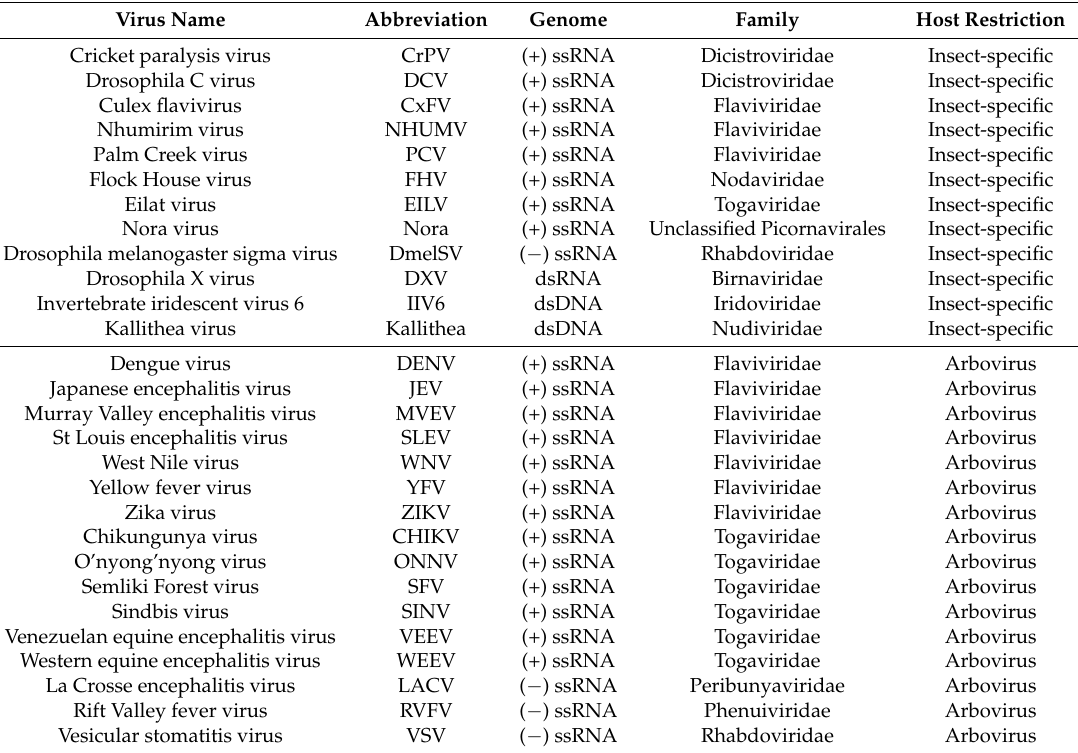
Table 1. Viruses discussed in this